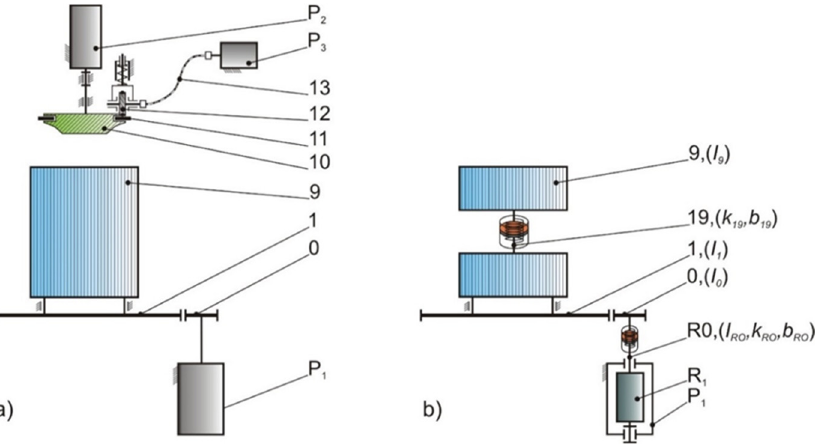
Figure 9. ( a ) Structure of the modified drive system of the cylinder, dial and roller cutter with controlled drives ( b ) considered mathematical model of the modified cylinder drive system.